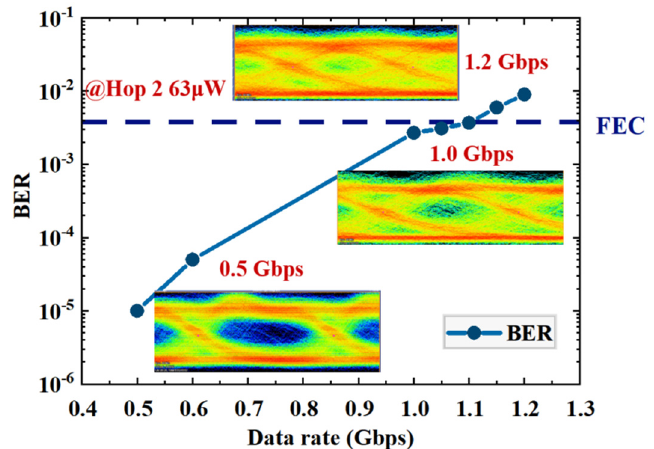
Figure 8. Measurement of real-time BER with OOK format from Hop 2. (Inset: the corresponding eye diagrams at the data rates of 500 Mbps, 1.0 Gbps, and 1.2 Gbps.)